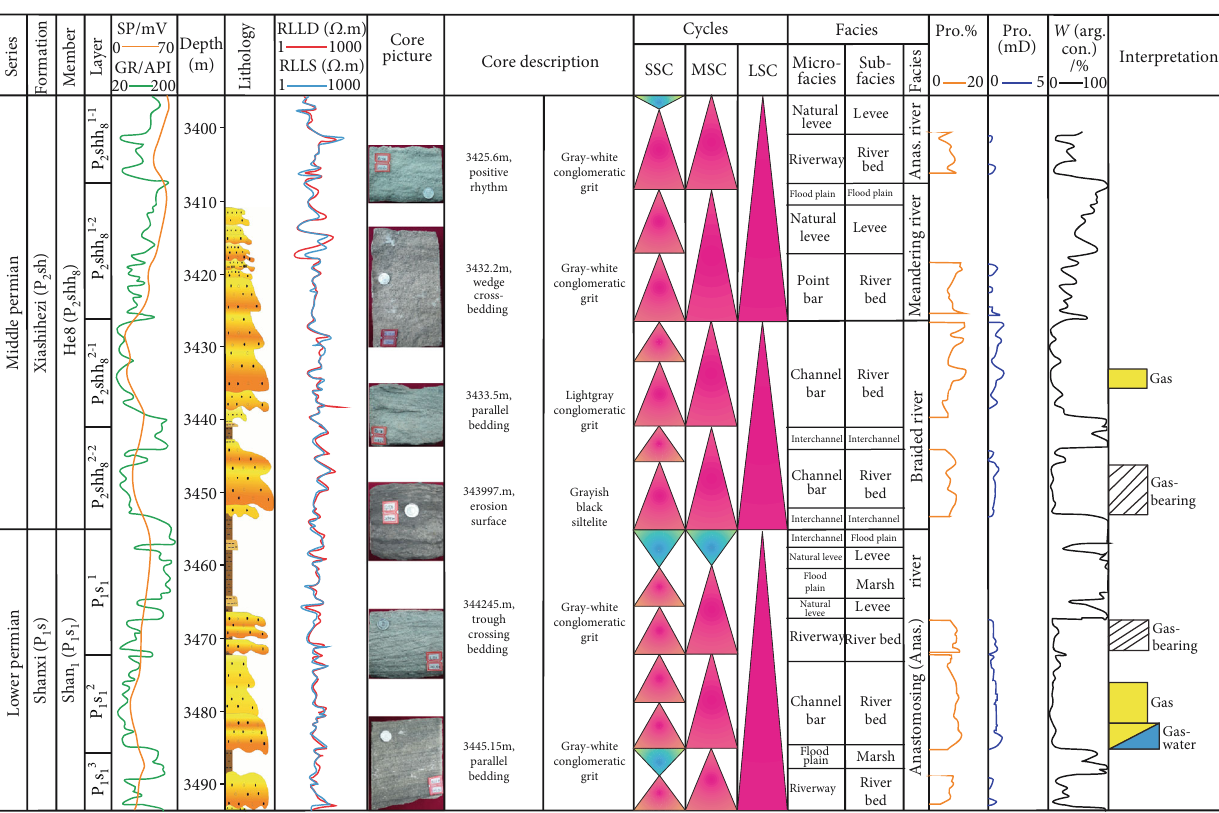
Figure 2: Sequence stratigraphy and core analysis of Well s373 in the western Sulige gas fi